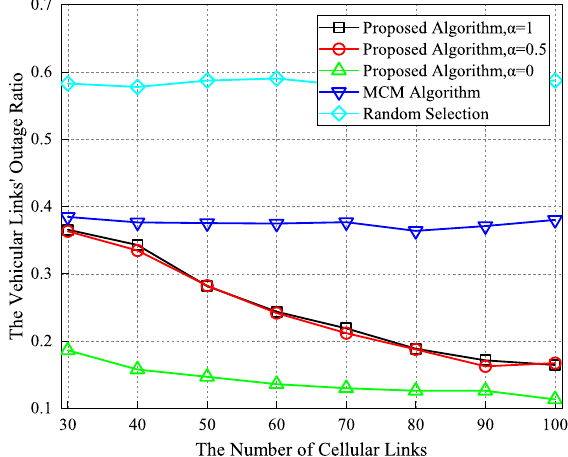
Figure 8. The vehicular link’s outage ratio performance of different schemes with varying V2I